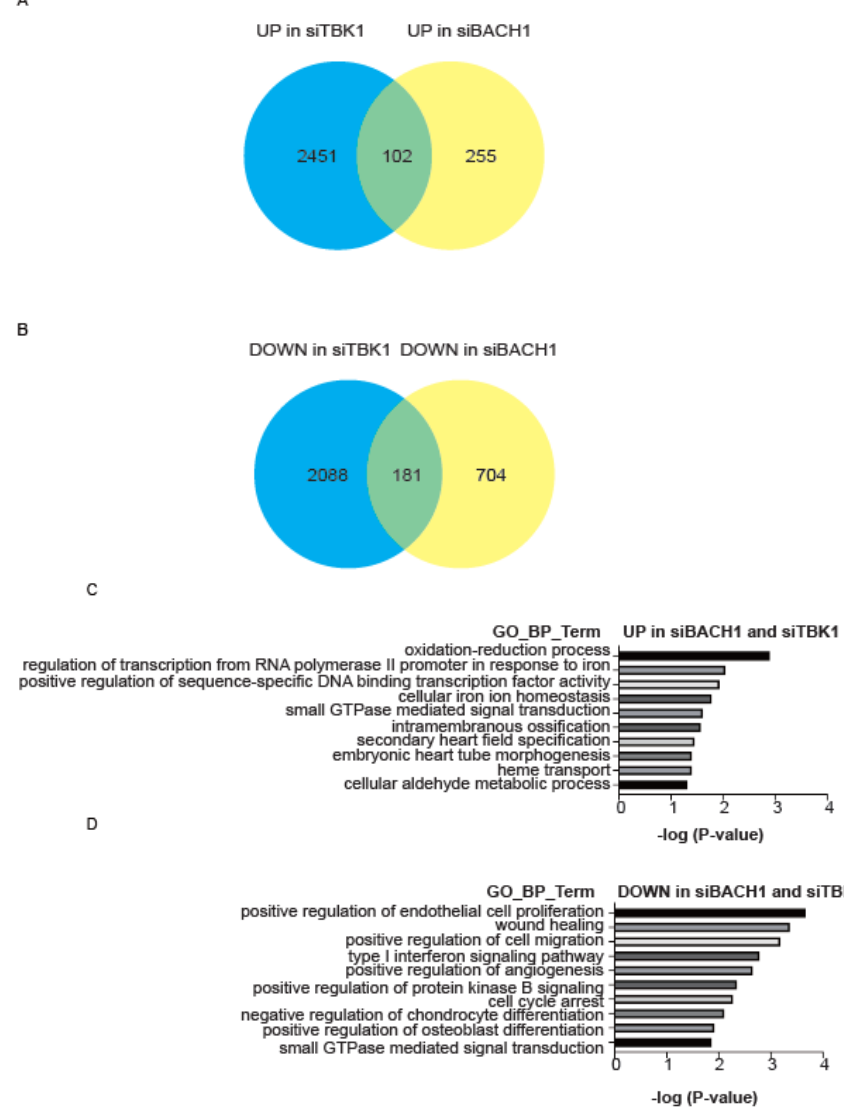
Figure 2. TBK1 and BACH1 regulate genes for iron homeostasis and cell migration. ( A , B ), AsPC − 1 cells with TBK1 siRNA or control siRNA were analyzed with RNA-sequence, resulting in upregulated ( A ) or downregulated ( B ) genes with TBK1 knockdown. These genes were compared with those affected with BACH1 knockdown, pointing to 102 common upregulated genes and 181 common downregulated genes in TBK1 -silenced and BACH1 -silenced AsPC − 1 cells. ( C , D ), Top 10 Gene Ontology (GO) biological process terms enriched in the upregulated genes ( C ) or downregulated genes ( D ) using DAVID for each considered group.